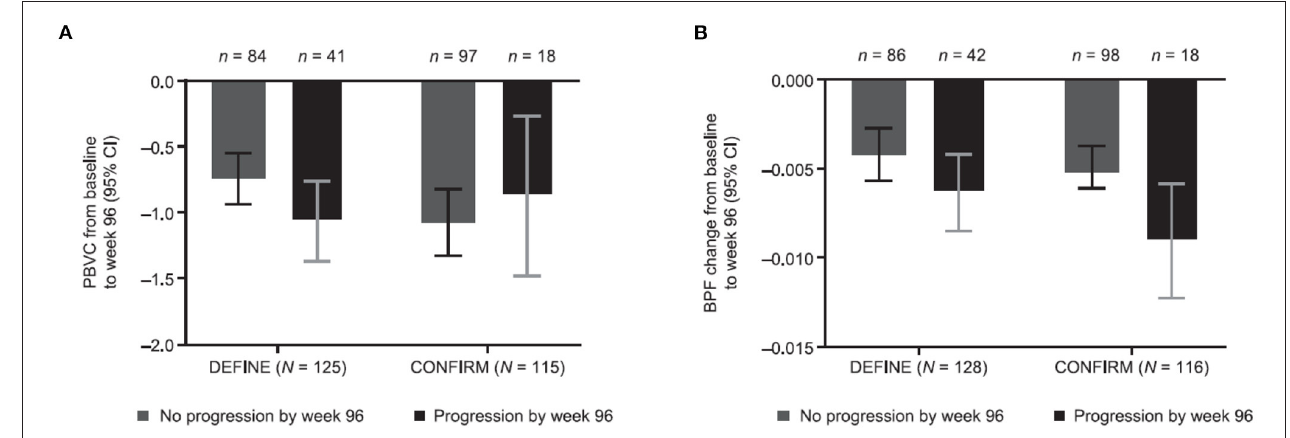
FIGURE 3 | Brain volume changes stratified by disability progression and study using (A) PBVC from original analyses and (B) BPF. Original PBVC values shown are model-based estimates, and 95% CIs are based on the mixed-effect model for repeated measures for baseline to week 96 in patients with and without disability progression in the DEFINE and CONFIRM placebo groups. PBVC, percentage brain volume change; BPF, brain parenchymal fraction.